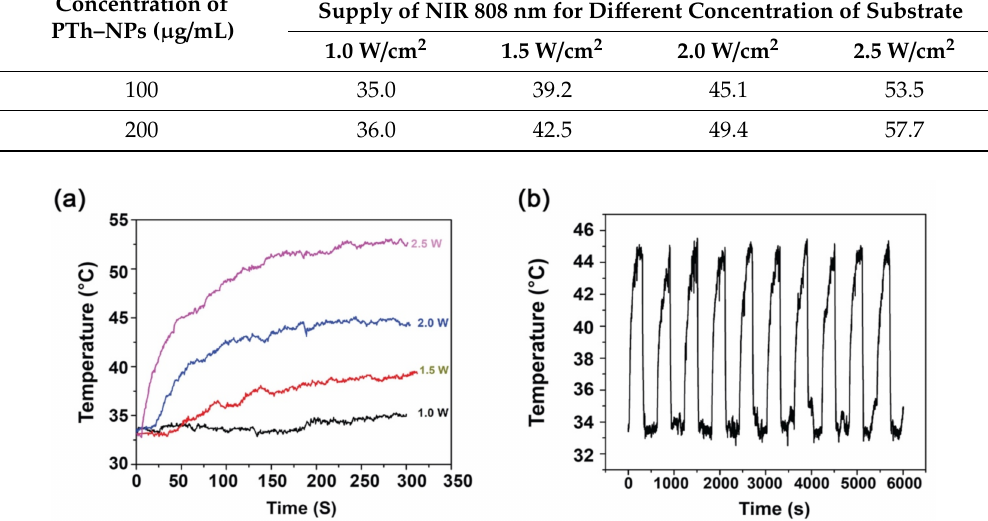
Figure 3. PhotothermalstudyofPTh–NPs. ( a )Photothermalperformanceofpolythiophenenanocomposites, and ( b ) photothermal stability curve by real time temperature record for PTh–NPs, 100 µ g / mL, under irradiation of 2.0 W / cm 2